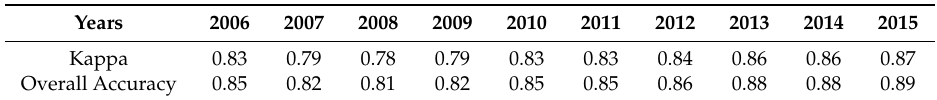
Table 2. Overall performances of the yearly classifications (kappa and overall accuracy) for the 2006–2015 period.